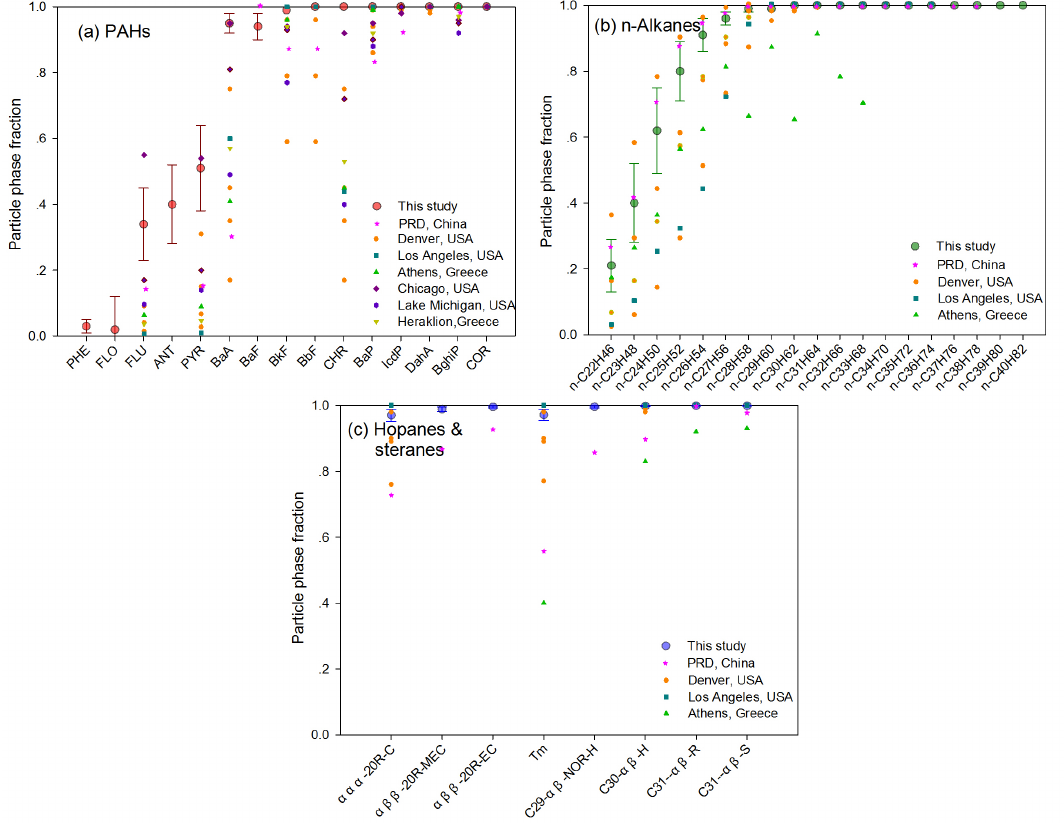
Figure 6. Average particle-phase fractions ( ϕ) of all NPOCs as compared with previous